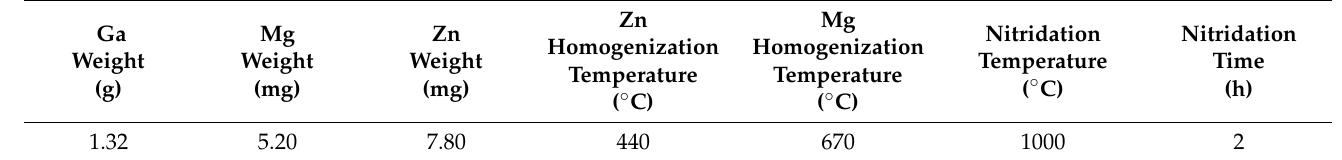
Table 1. Parameters considered in the synthesis of Mg-Zn co-dopedGaN powders.